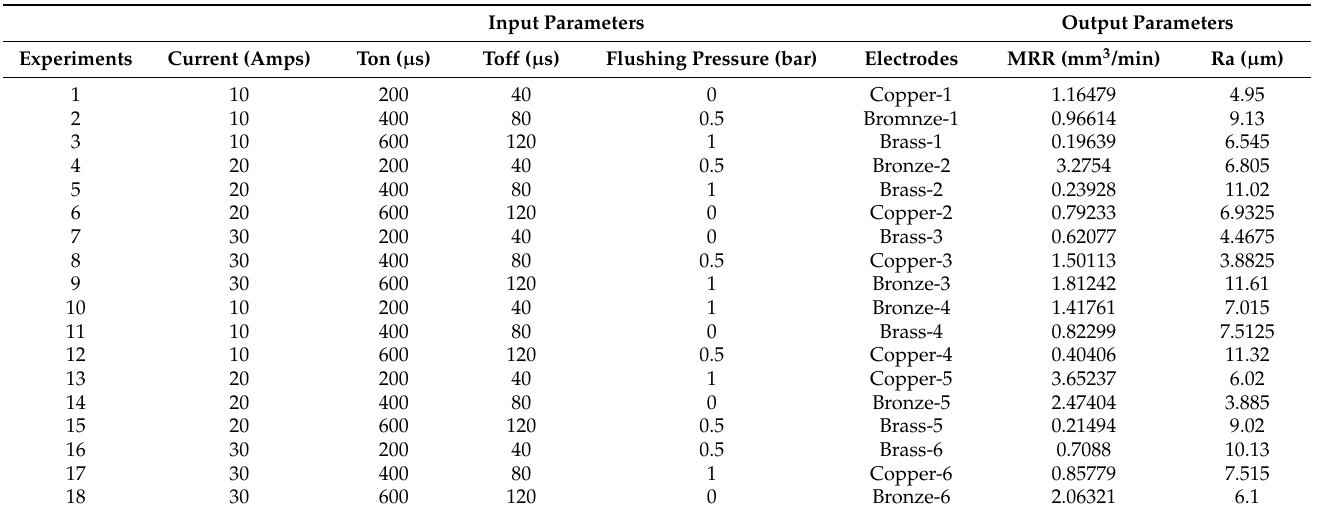
Table 3. Experimental data of MRR and SR.